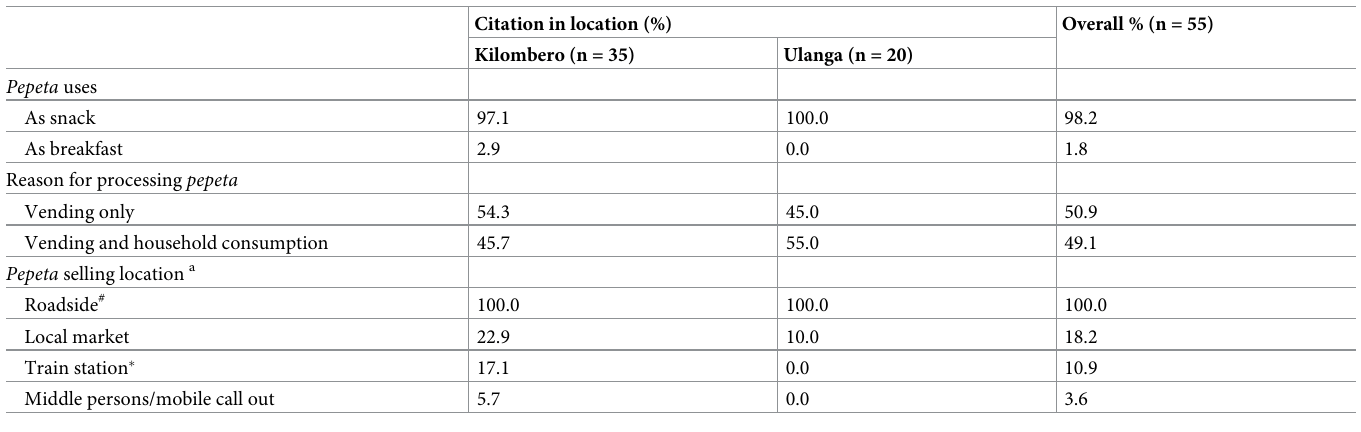
Table 9. Overview of pepeta trade in the study